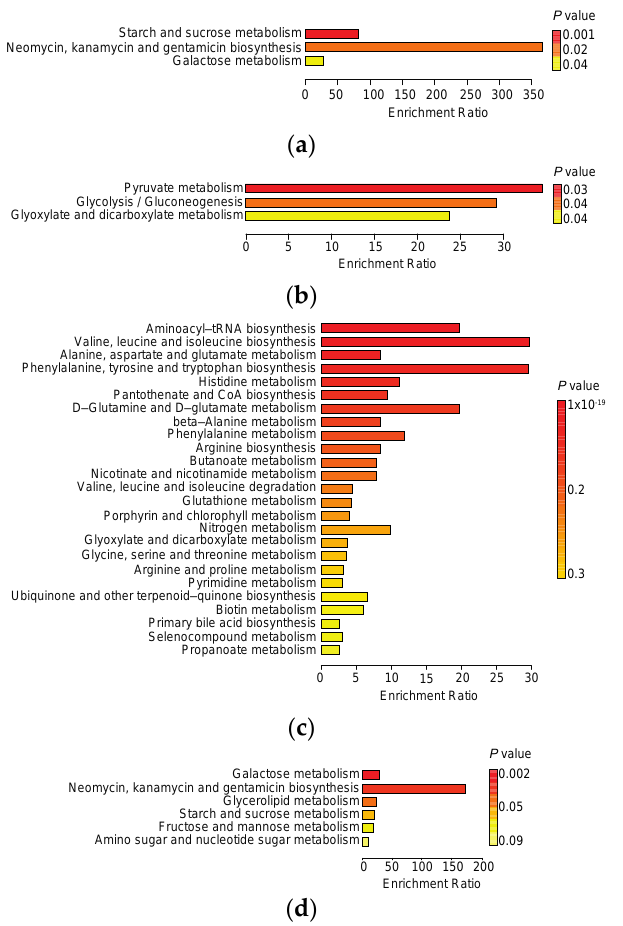
Figure 4. Summary plots of results from metabolite set enrichment analysis. Over representation analysis showed metabolite sets that were represented more among ( a ) Caesarean-delivered, ( b ) vaginally delivered, ( c ) formula-fed, and ( d ) exclusively breast-fed infants.